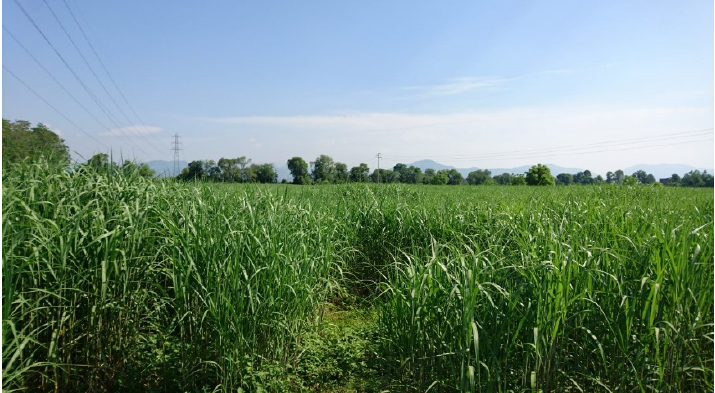
Figure 5. Miscanthus x giganteus crop, station 4 (photo P. Gaini).